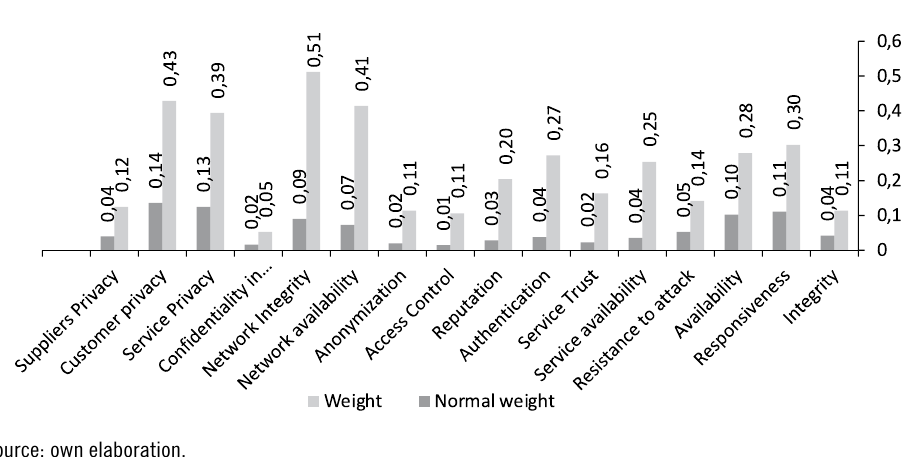
Figure 2. Normalized weight and rating of IoT supply chain security criteria and